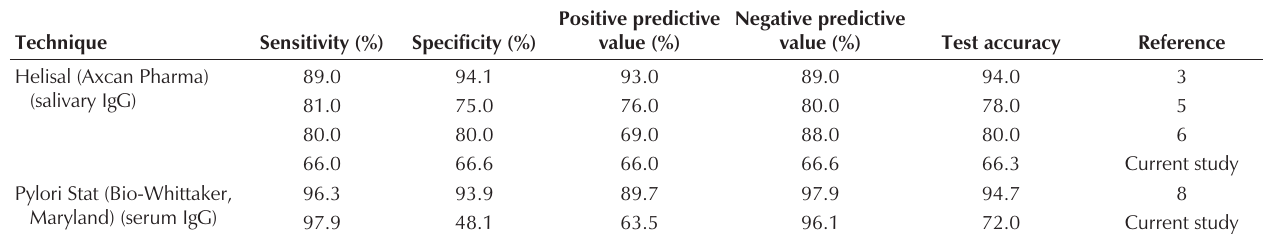
Comparison of published test characteristics for the detection of Helicobacter pylori with the result of the current study Technique Sensitivity (%)